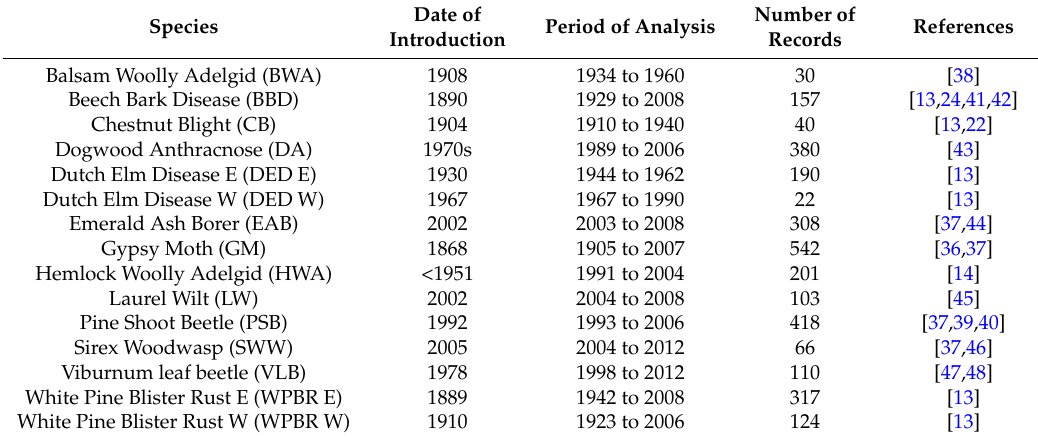
Table 1. Invasive species included in the analysis with the period of record and number of records.